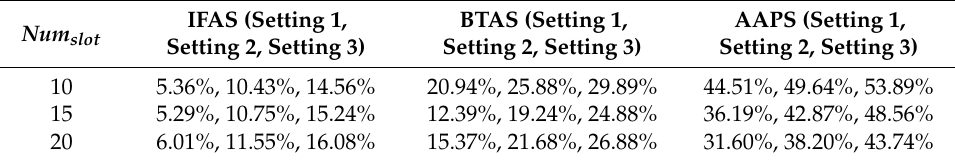
Table 9. The improvement of delay compared with the traditional